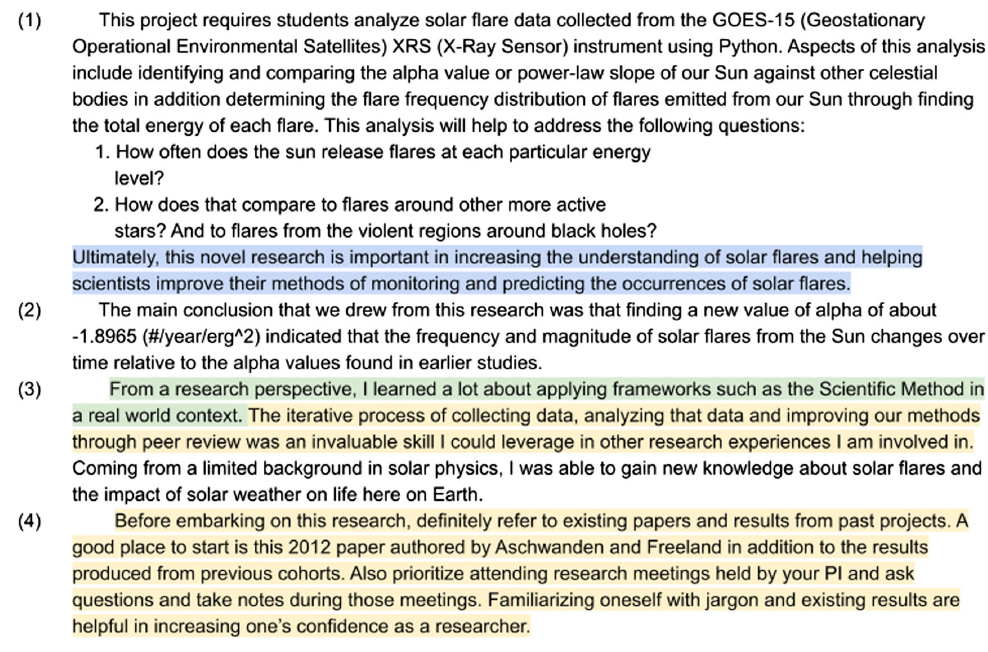
FIG. 2. Student 1 ’ s response to the memo assignment. Green highlighting corresponds to a “ direct authenticity ” code, blue highlighting corresponds to an “ indirect authenticity ” code, and yellow highlighting corresponds to a “ research components ”